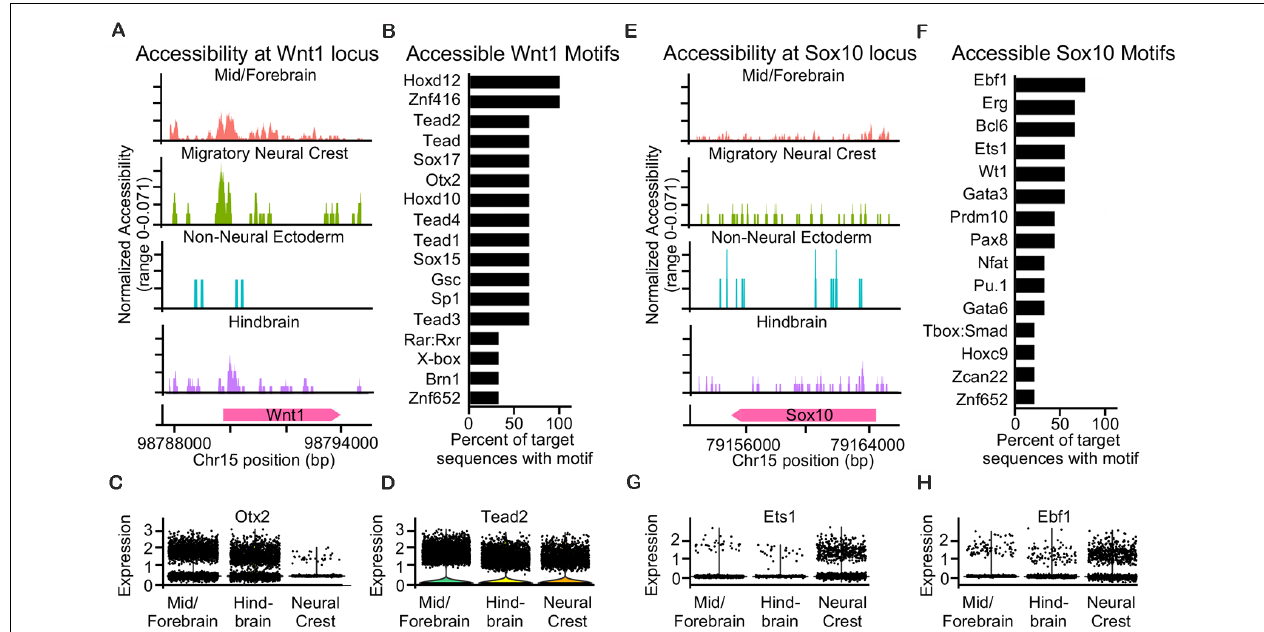
FIGURE 4 | Single-cell ATAC sequencing reveals accessible motifs near Wnt1 in the neuroepithelium and Sox10 in neural crest. (A) Coverage plot of accessibility at the Wnt1 locus in ectoderm-derived cell populations. (B) Bar plot of accessible motifs at the Wnt1 locus. (C) Dot plot showing expression of Otx2 and (D) Tead2 transcription factors with accessible predicted motifs at the Wnt1 locus. (E) Coverage plot of accessibility at the Sox10 locus in ectoderm-derived cell populations. (F) Bar plot of accessible motifs at the Sox10 locus. (G) Dot plot showing expression of Ets1 and (H) Ebf1 transcription factors with accessible predicted motifs at the Sox10